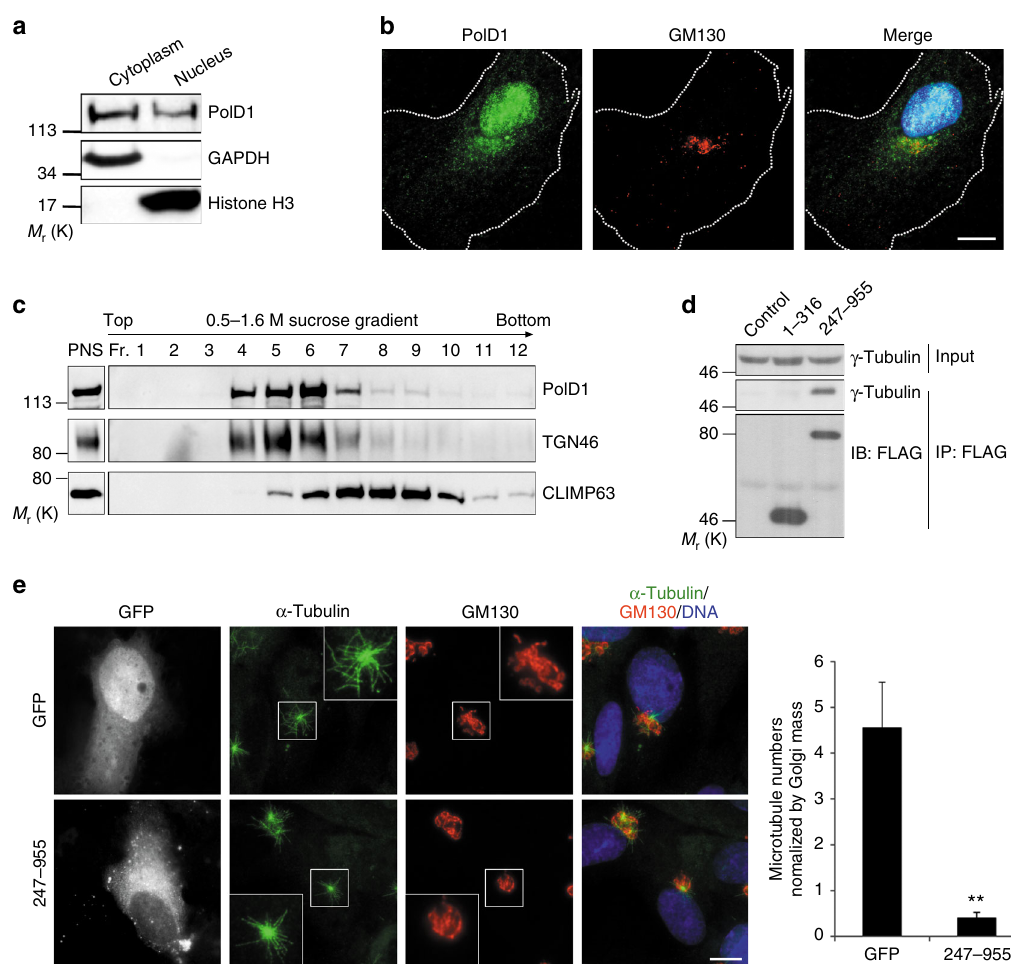
Fig. 5 Subcellular distribution of PolD1. a RPE1 cell lysates were fractionated into cytoplasmic (Cytoplasm) and nuclear (Nucleus) fractions, and an equal proportion of each fraction was immunoblotted. The cytoplasmic protein GAPDH and the nuclear protein histone H3 were probed as fractionation controls. b RPE1 cells were double-stained for PolD1 and GM130. The images show a representative cell of at least three experiments; the white dashed lines indicate the cell boundary. The PolD1 intensity at the Golgi is ~ 22% of that in the nucleus. c The PNS from RPE1 cells was fractionated by equilibrium centrifugation over a sucrose gradient (0.5 – 1.6 M). Membranes were then pelleted, and each fraction (50%) and the PNS (4%) were analyzed. d The PolD1 fragments 1 – 316 and 247 – 955 were FLAG-tagged and ectopically expressed in HEK293T cells, and the extracts were used for anti-FLAG immunoprecipitation. The lysate inputs and the immunoprecipitates were analyzed by immunoblotting ( IB ). Control, FLAG vector. e A microtubule regrowth assay was performed on RPE1 cells transfected with GFP or GFP fused with the PolD1 fragment 247 – 955. The cells were then stained for microtubules (anti- α -tubulin) and GM130. The images shown are representative of at least three experiments (20 cells expressing GFP or GFP-tagged 247 – 955 at similar levels were analyzed at 1.5 min of regrowth). The numbers of Golgi-associated microtubules were determined and normalized by the Golgi mass. The data are presented as means ± s.d. and are representative of three independent experiments; *** p < 0.001, two-tailed, unpaired student ’ s t -test. Scale bars , 10 μ